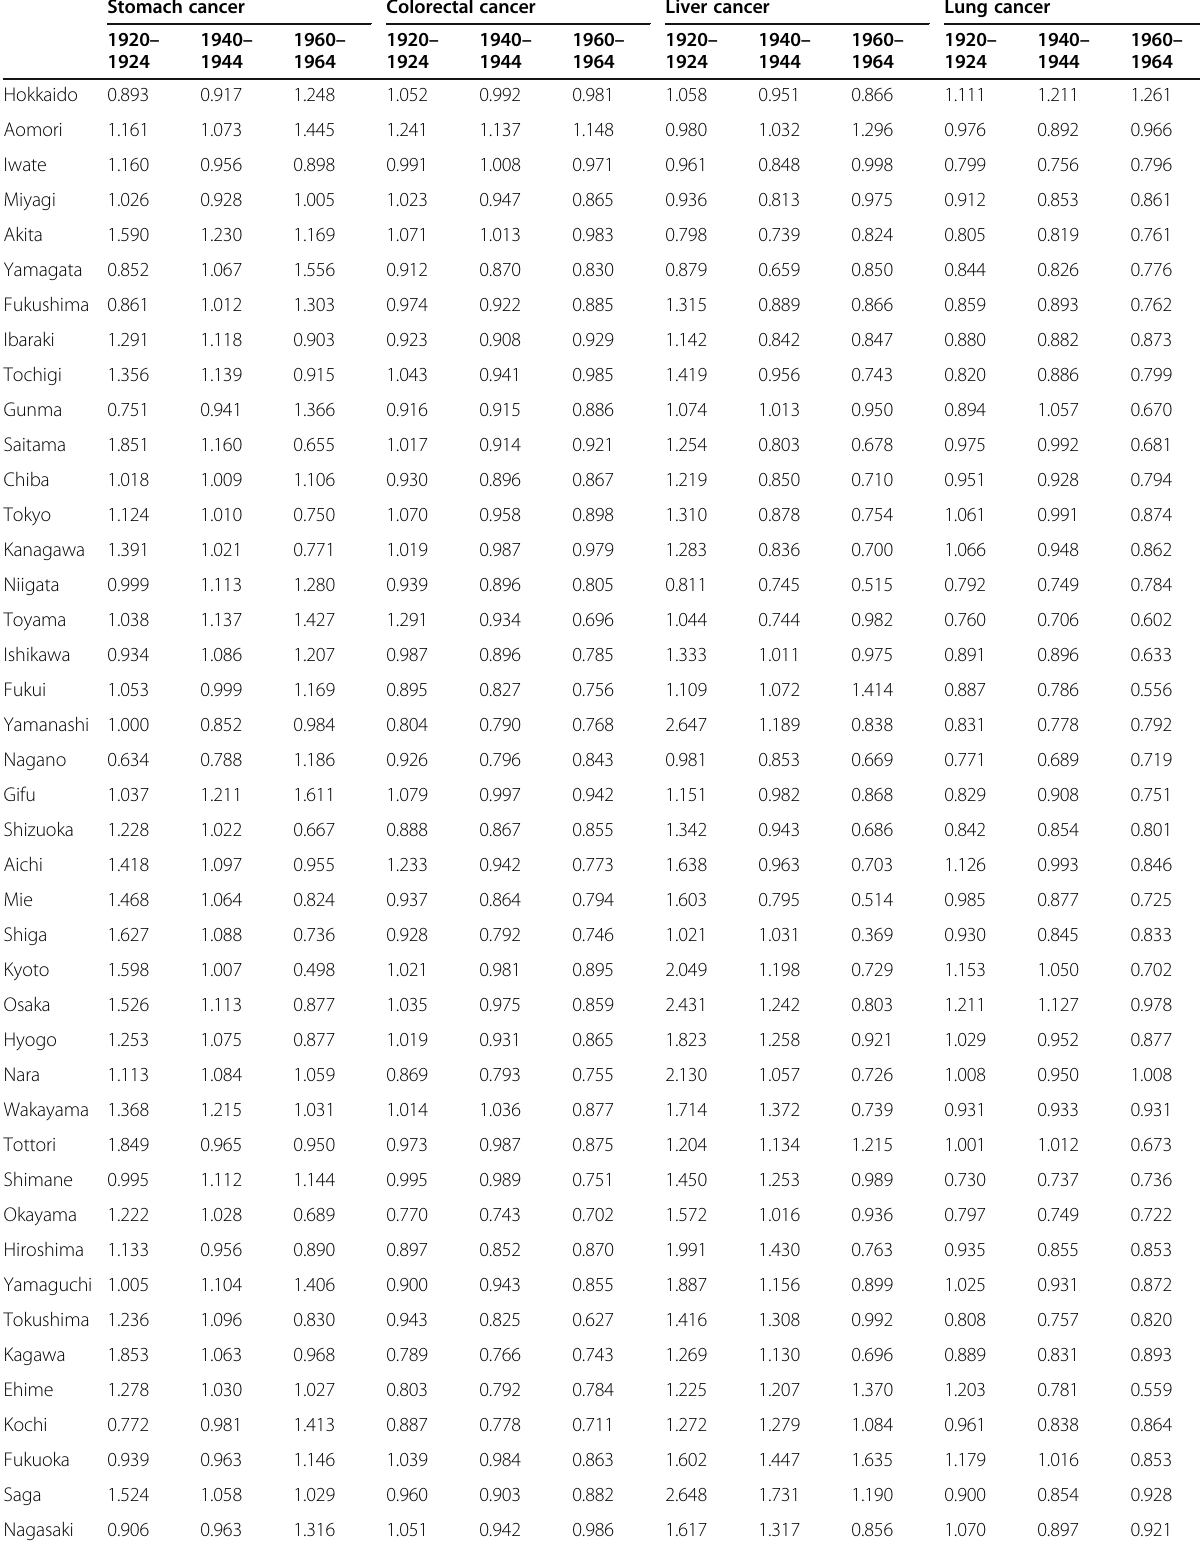
Table 5 Mortality rate ratio of a prefecture to all of Japan on each cohort in women Stomach